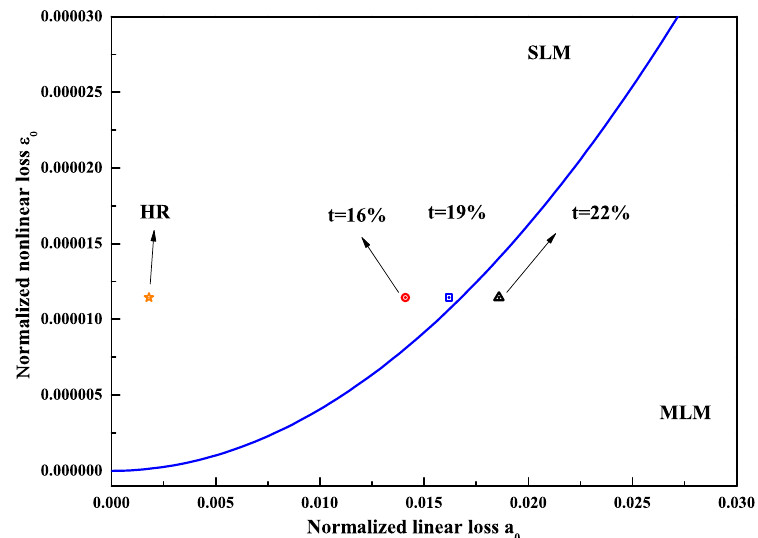
Figure 1. Dependence of nonlinear loss ε 0 on linear loss α 0 for the criterion condition of SLM operation [21]. Reprinted with permission from [21] c (cid:13) The Optical